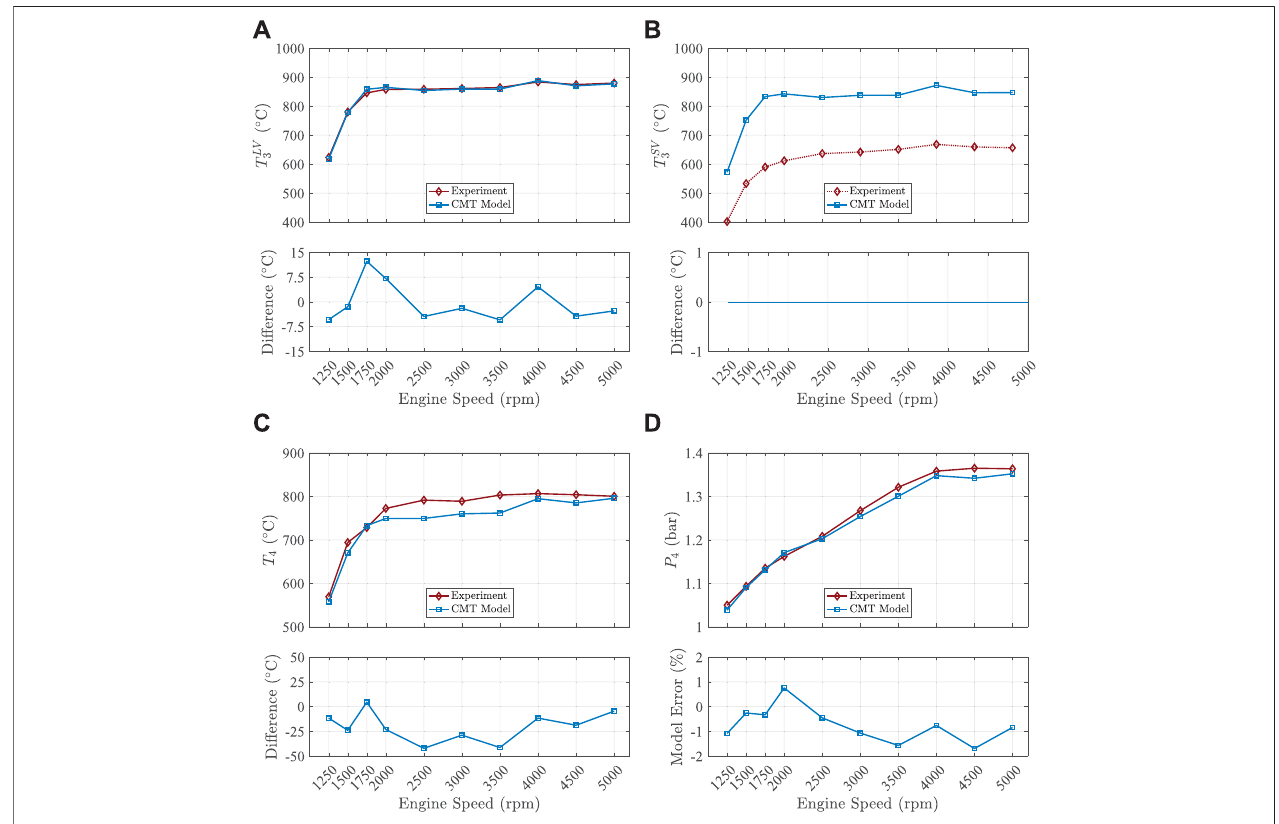
FIGURE 15 | Validation parameters of SCV opened simulation. Outputs from the CMT-DETCM model compared against the experimental data at different engine speeds. (A) Turbine inlet temperature LV; (B) turbine inlet temperature SV; (C) turbine outlet temperature; (D) turbine outlet pressure.